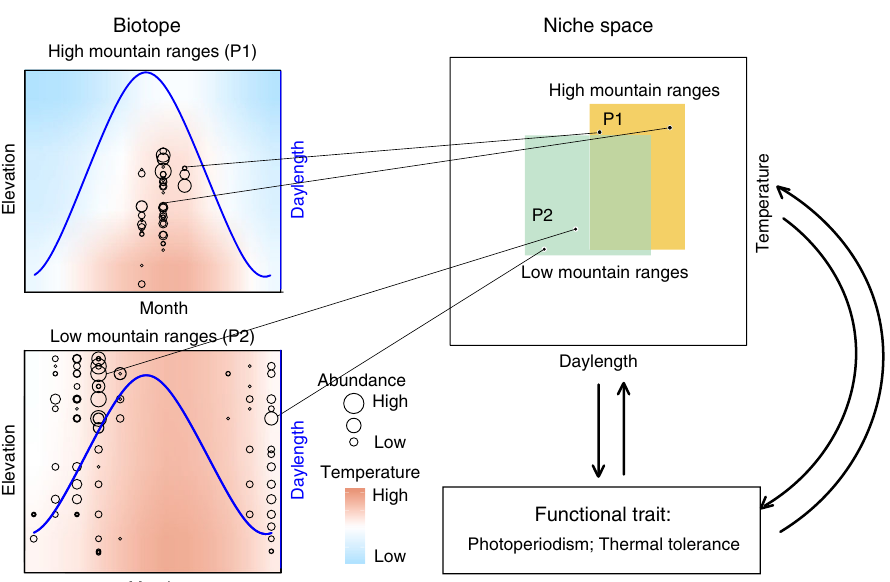
Fig. 1 Illustration of the concept of niche-biotope duality for beetle populations on high and low mountain ranges. The geographical biotope is depicted by two dimensions, month and elevation, which correspond to the niche space of daylength (blue line) and temperature (the blue to red heatmap). The size of the open circles represents the abundance at each elevation in a given month. The black lines connect representative beetle abundances in high mountain ranges (P1) and low mountain ranges (P2) at different months and elevations of the biotope, with their corresponding points in the niches of the two populations. The yellow and green rectangles represent the size of the niche spaces of P1 and P2 along daylength and temperature gradients, respectively. The biotope fi gures are based on data from Wulai for the low mountain range and Mt. Jiajin for the high mountain range. Functional traits (indicated by arrows) represent the traits used to determine if they correspond to different niche spaces (i.e., daylength and temperature) occupied by different populations. Our fi gure is based on Figure 101 of Hutchinson 29 and Figure 1 of Colwell and Rangel 27